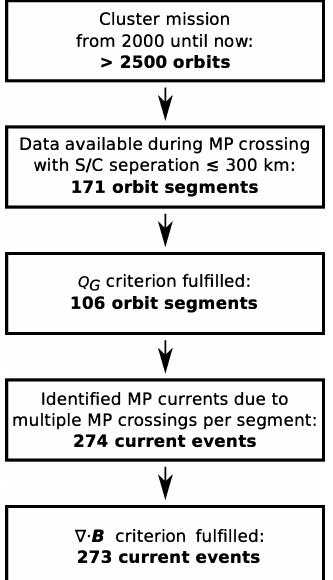
Figure 4. This illustration of the data selection process shows the shrinking number of suitable data sets. From over 2500 Cluster or- bits only a few orbit segments match the spatial requirements and the quality criterion for our day-side magnetopause current investi- gation.